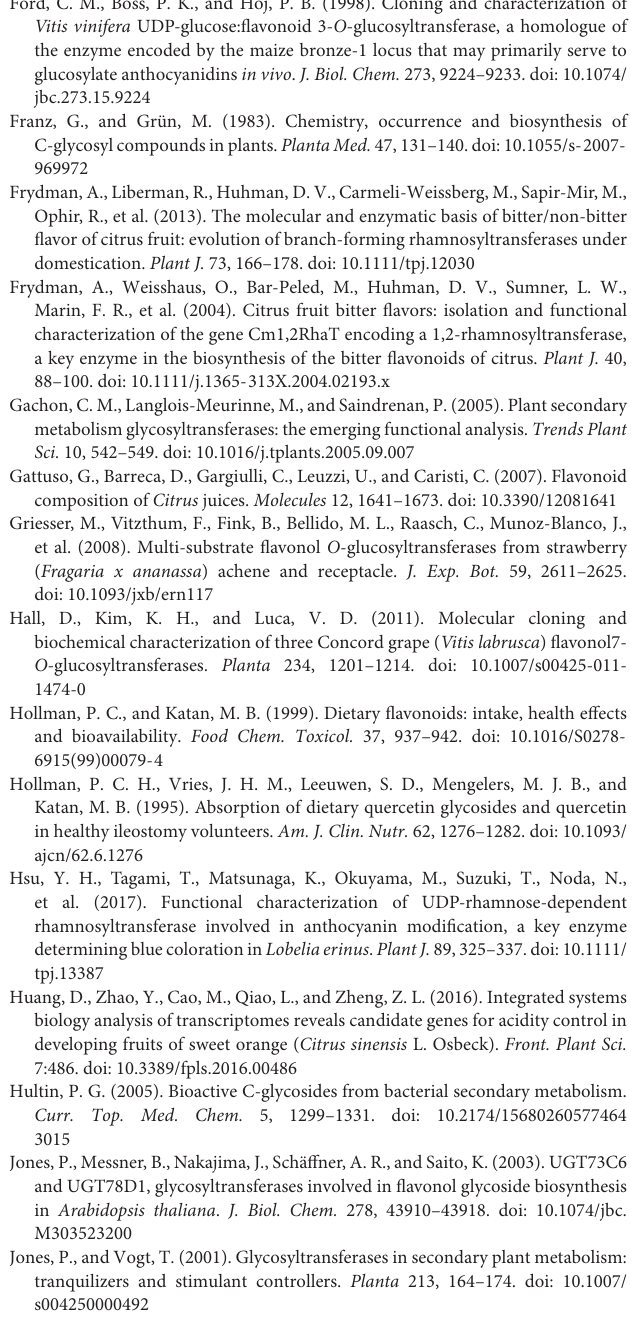
TABLE S1 | Primers sequences used in experiments. TABLE S2 | Identification of flavonoids in fruit peels of sweet orange by UPLC-Q-TOF-MS. TABLE S3 | MS analyses of products in Figures 6 , 7